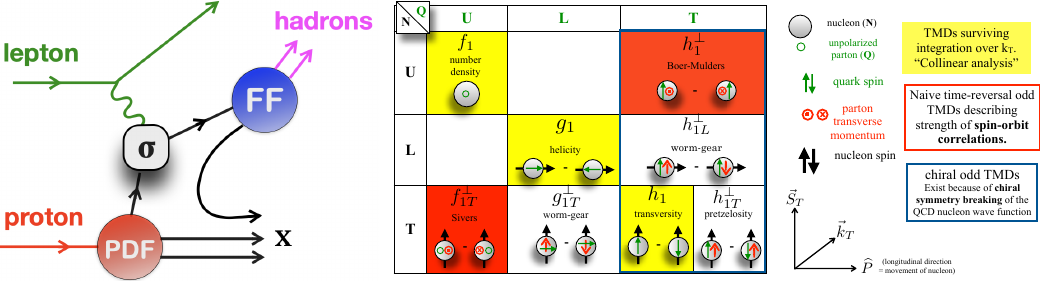
Figure 1: Left: semi-inclusive DIS. Right: TMD PDFs at leading twist for unpolarized (U), longitudinally (L) and transversely (T) polarized partons (Q) and nucleons (N). tation function (FF), which encodes the fragmentation of a quark into a final-state